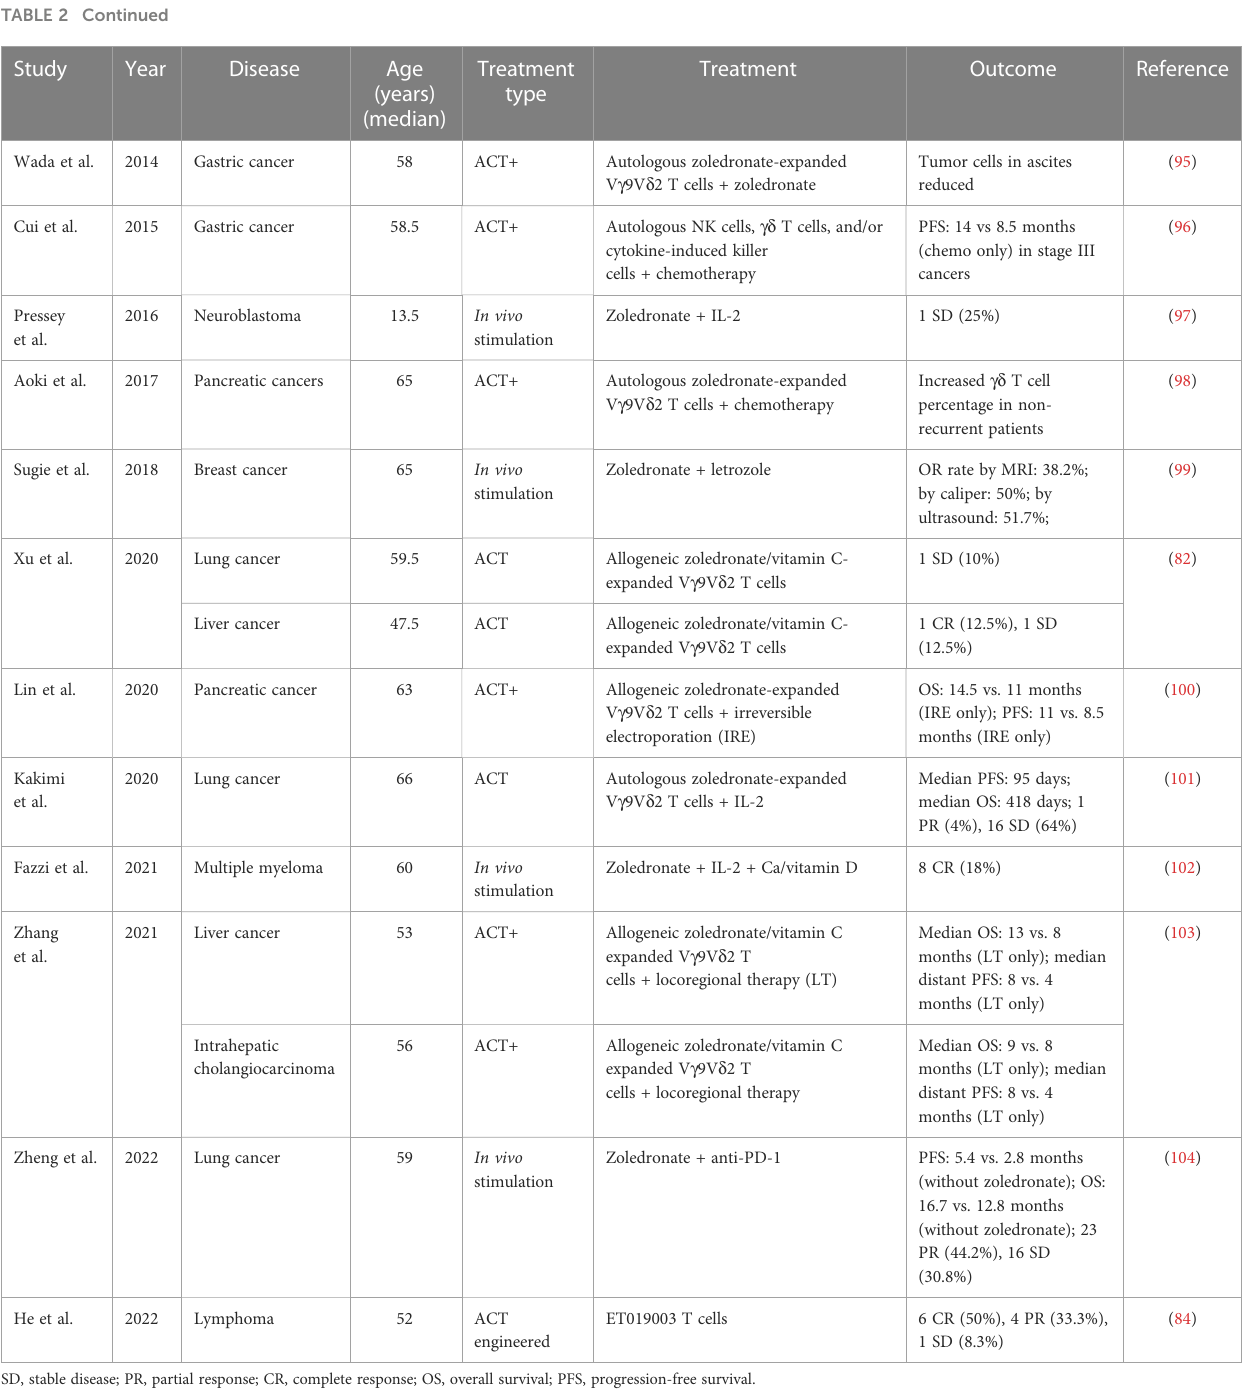
all cases with ACT (Figure 4B, lower panels); however, the outcomes were moderate (Figure 4B, upper panels). Out of 38 female solid cancer patients, three reached OR, all with ACT+ treatment. Although treatment strategy matters, it is interesting to note that, among the ACT+-treated tumors, these positively responding cancers were all female-related (Figure 4B, upper left, pie chart). However, the sample size was too small to draw a conclusion. Among male solid cancer patients, 55% were treated with ACT, two patients reached OR, and the only CR patient received ACT+ treatment (Figure 4B, right panels).